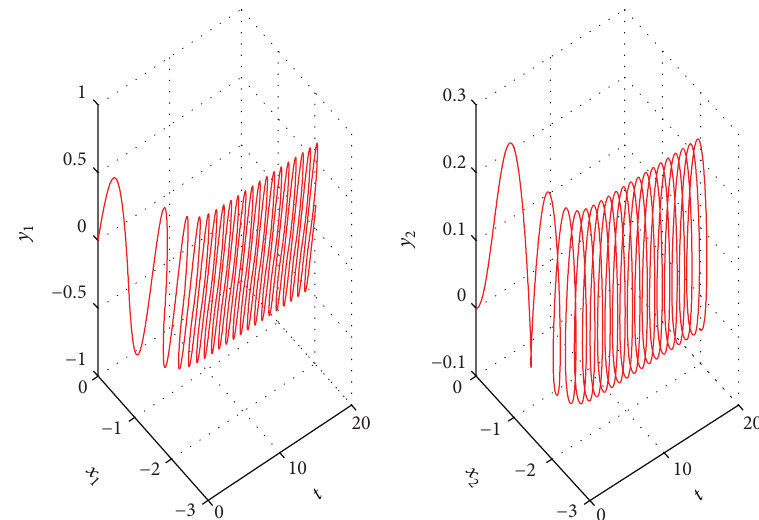
Figure 2: State trajectories of the real and imaginary parts of system